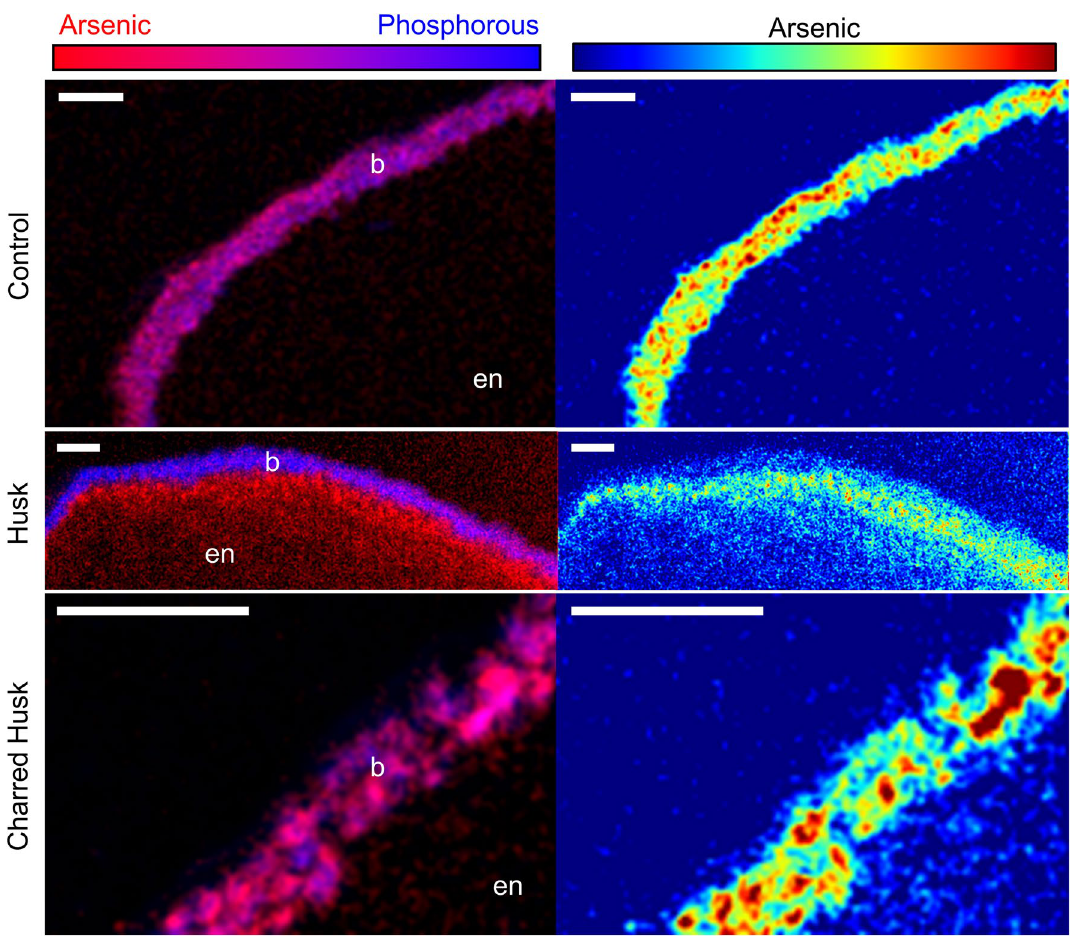
Figure 3. Effect of Si-rich soil amendments on As localization in M206 rice grains. Bicolor plots show distribution of As (red) and P (blue) at the edge of a longitudinal thin section. For As plots, warmer colors correlate with higher concentrations of As. Grain from each plant was 53%, 85%, and 55% organic As for control, husk, and charred husk treatments, respectively. Scale bar is 100 μm. b, bran; en,